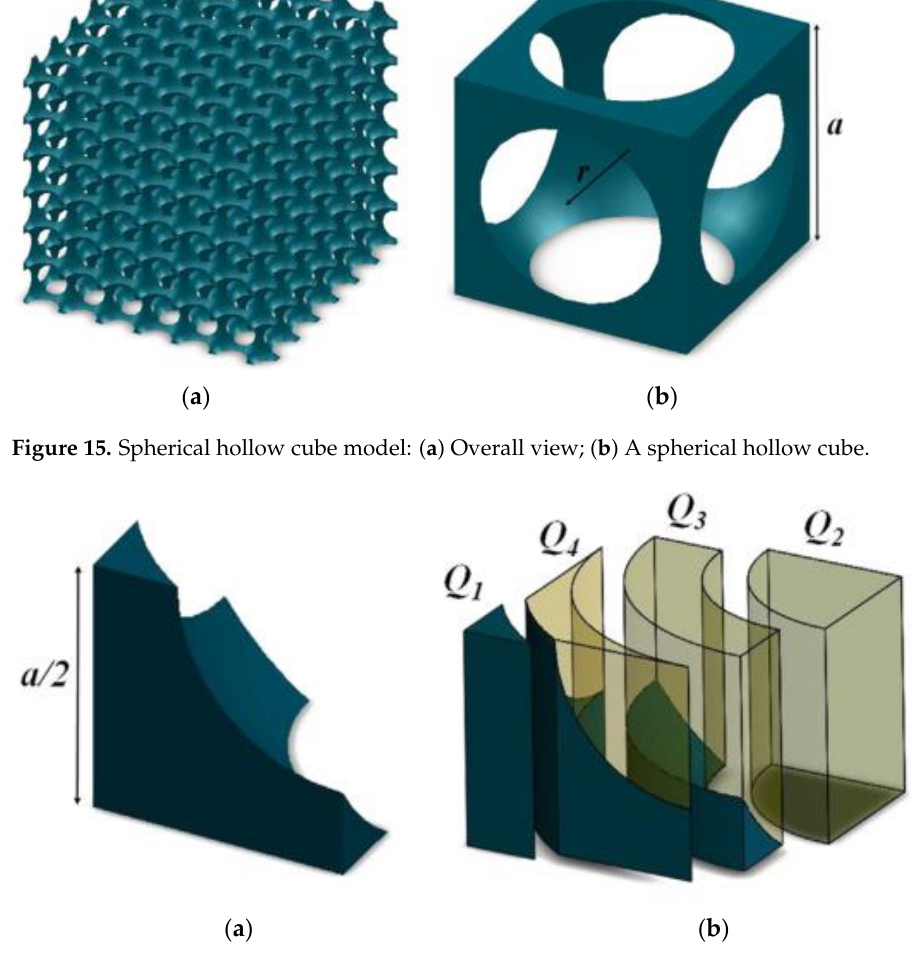
( c ) Figure 17. Regular geometric structure: ( a ) Cubic packing structure; ( b ) The face-centered cubic packing structure; ( c ) The cubic array of intersecting spheres. Similar to Zeng et al., Wei et al., Dan et al., He et al., and Dan et al., in the research of many domestic and foreign scholars [71,72], the cross ball rod structure has also been used to characterize the nano-porous structure of aerogel matrix materials. In fact, most studies on equivalent circuit method use some regular structures to characterize the nano-porous structure of aerogel materials, while the complex nano-porous structure of aerogel mate- rials is ignored. In order to make the calculation results more accurate, Xie et al. [41], Pia